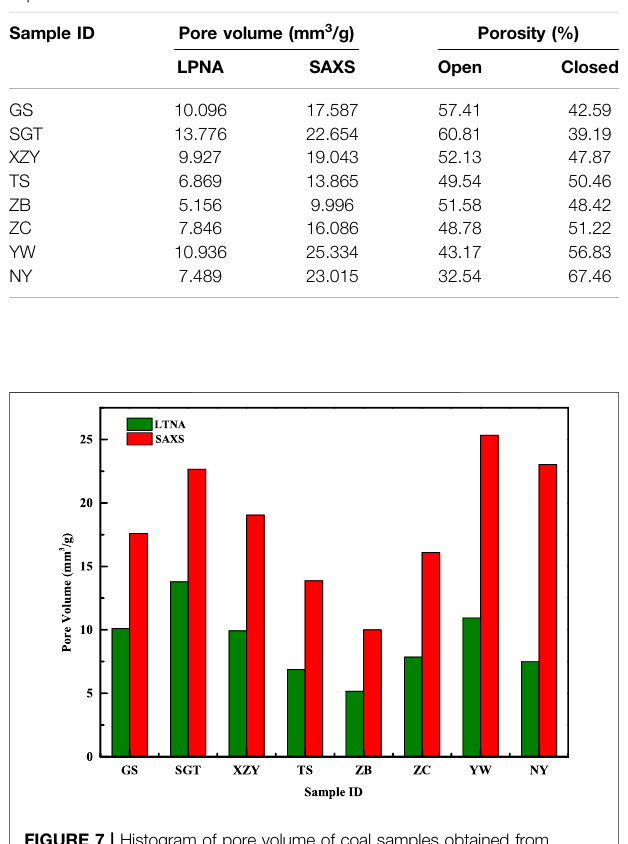
FIGURE 7 | Histogram of pore volume of coal samples obtained from LTNA and SAXS experiments.